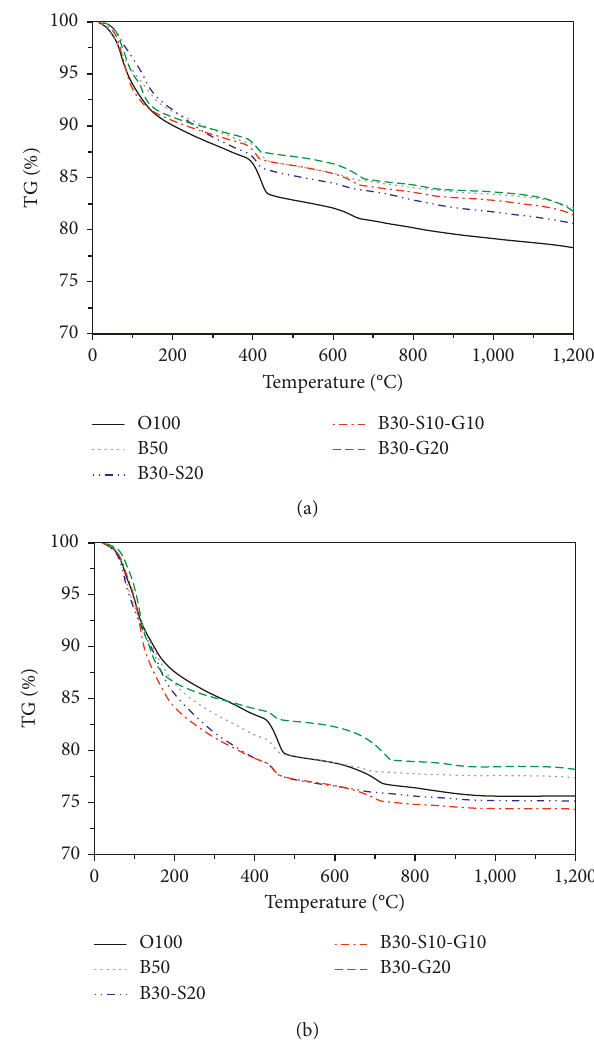
Figure 8: Thermogravimetric analysis with binder types at (a) 3 days and (b) 91